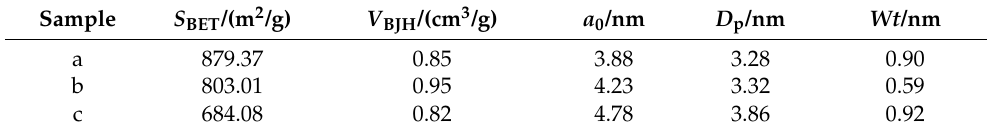
Table 3. Pore structure parameters of samples.